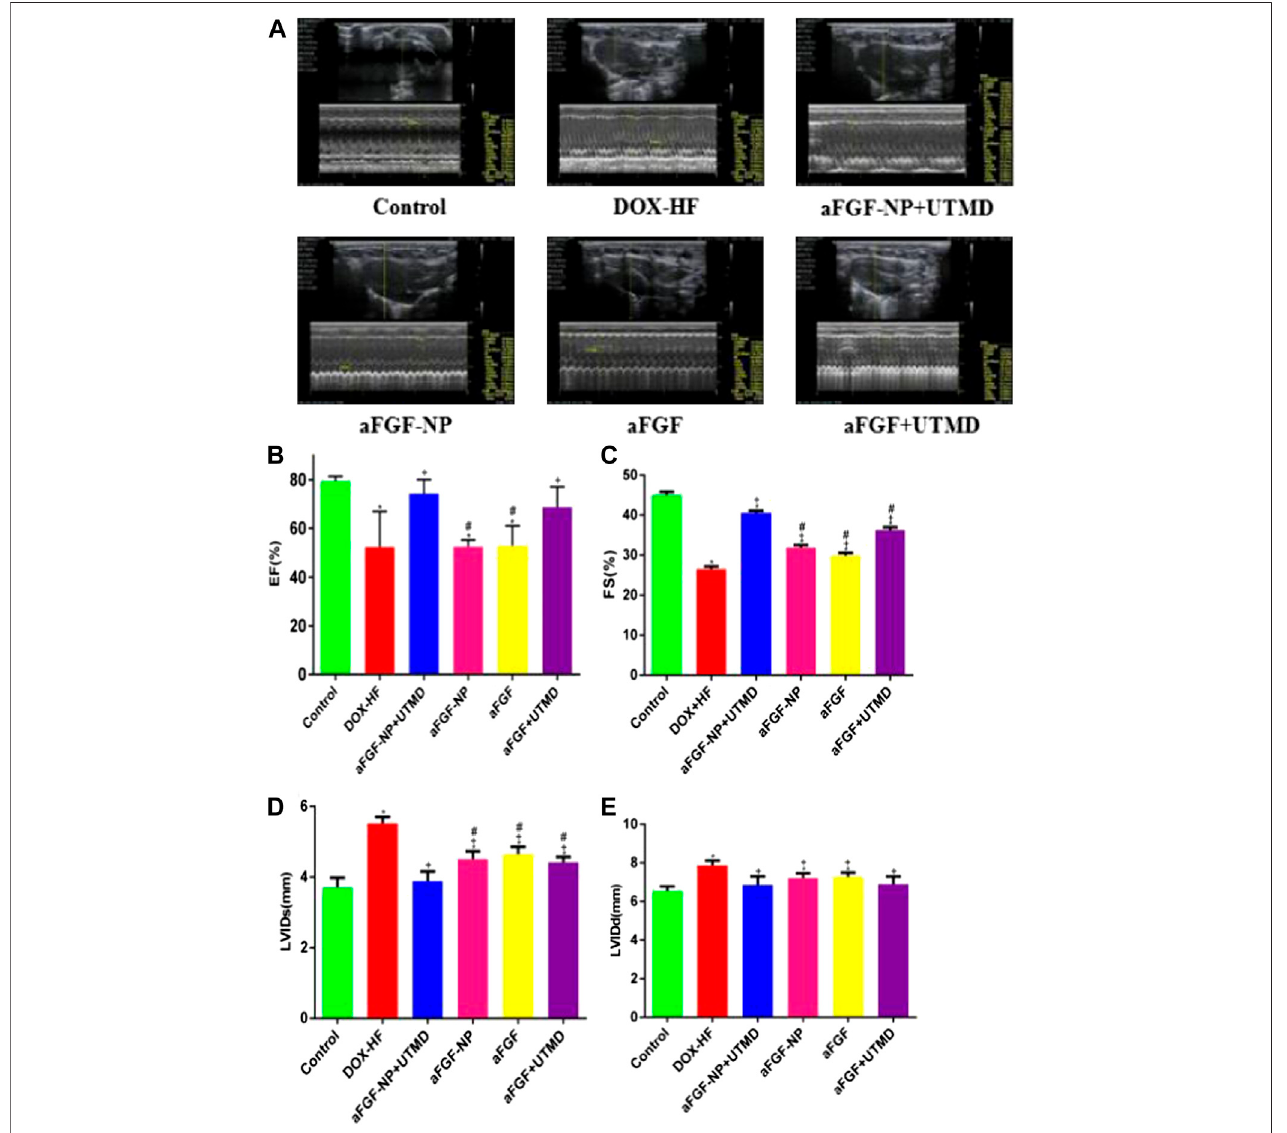
FIGURE2 | The aFGF – NP+ CPMBs combined withUTMD preventedleft ventriculardysfunctionin DOX – HFrats. (A) Representative M – mode echocardiographic pictures of left ventricular function; (B – E) Quantitative analysis of EF(%), FS(%), LVIDs and LVIDd in each group. All data are expressed as mean ± SEM. * p < 0.05 vs. Control group; + p < 0.05 vs. DOX – HF group; # p < 0.05 vs aFGF – NP + UTMD group. aFGF, acidic fi broblast growth factor; NP, nanoparticles; CPMBs, cationic lipid microbubbles;UTMD,ultrasoundtargeted microbubbledestruction;DOX,doxorubicin;HF,heartfailure;EF,ejectionfraction;FS,fractionalshortening;LVIDs,Left ventricular internal diameter – systole; LVIDd, Left ventricular internal diameter-diastole. Reduction the level of myocardial injury and oxidative stress in DOX-HF.